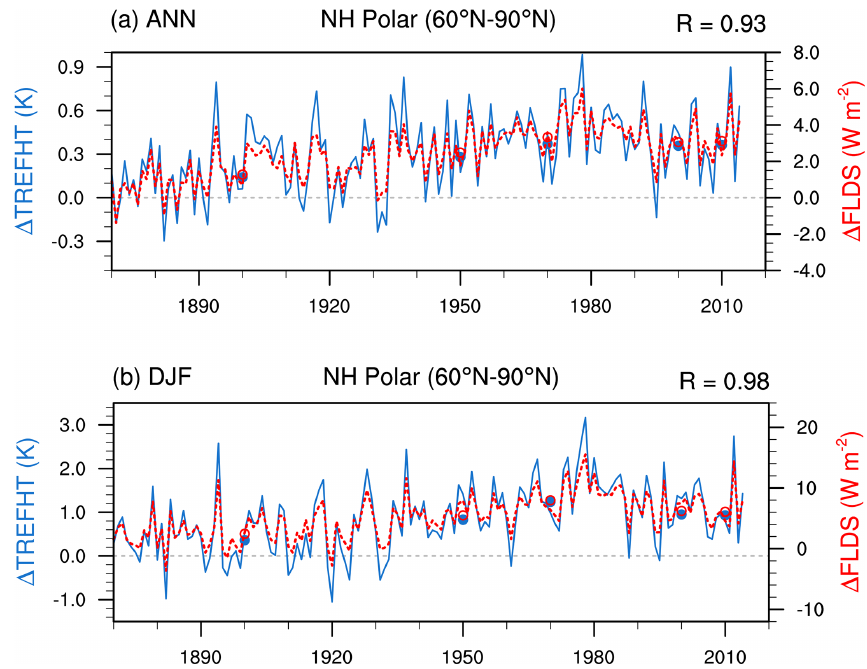
Figure 18. Annual (a) and boreal winter (b) mean changes in near-surface temperature at 2m ( (cid:49) TREFHT, K, in blue) and downward longwave radiation flux ( (cid:49) FLDS, Wm − 2 , in red) over the NH polar region due to the anthropogenic aerosol effects. Both the AMIP (lines) and nudged (dots and circles) simulations are shown here. See Sect. 7 for